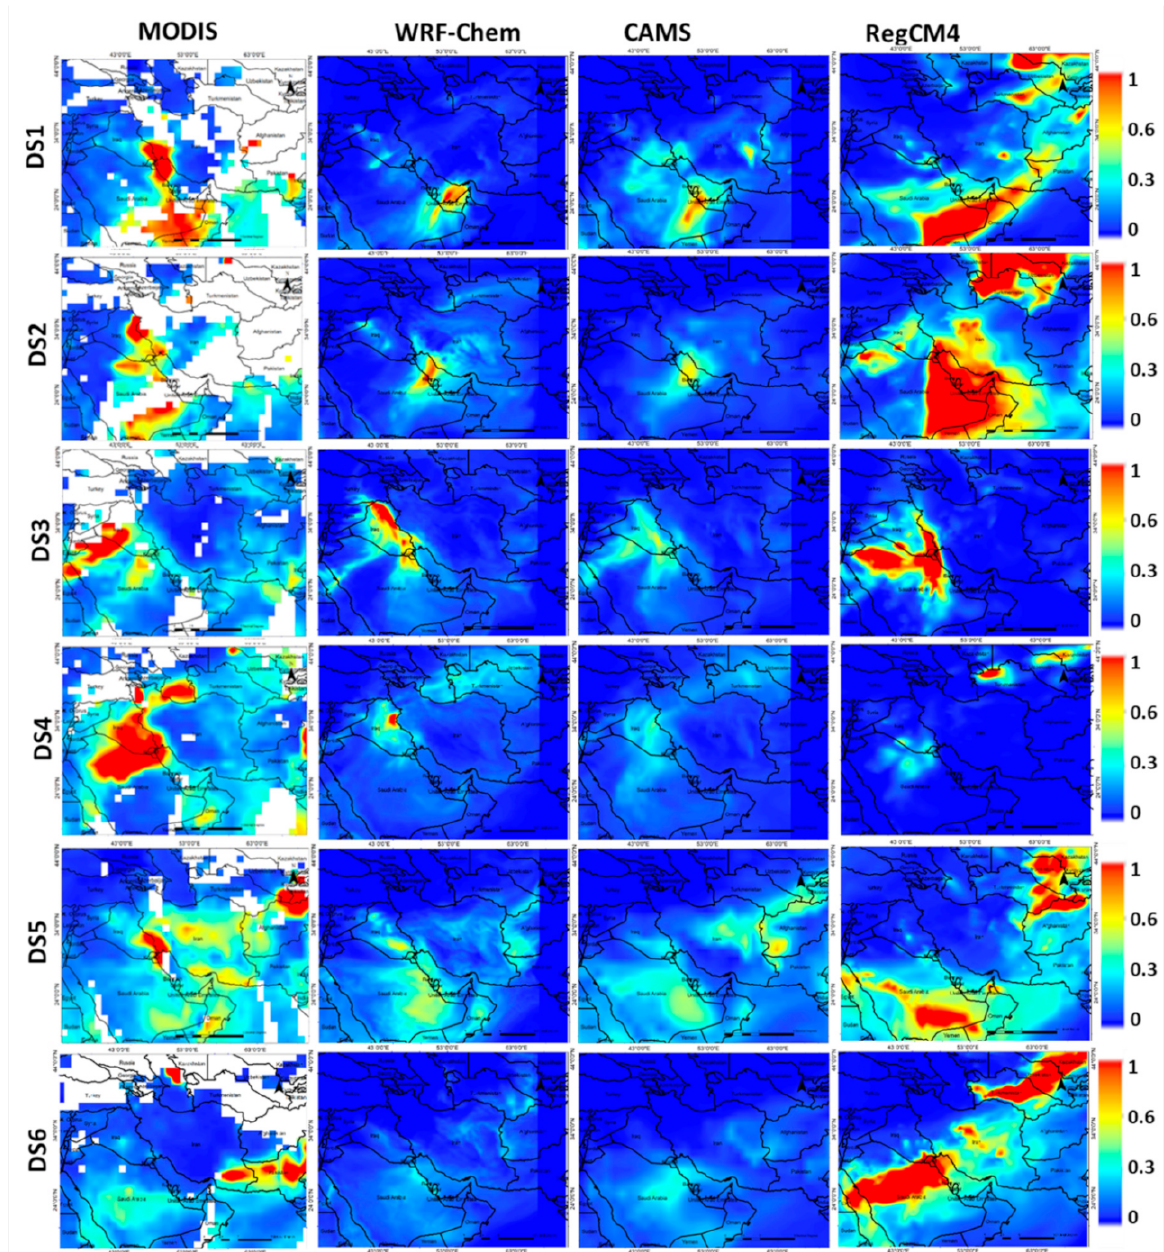
Figure 4. Spatial distribution of the Terra-MODIS aerosol optical depth (AOD 550 ) and simulated AODs (at 9:00 UTC) via Weather Research and Forecasting model coupled with Chemistry (WRF-Chem), Copernicus Atmospheric Monitoring Service (CAMS) and Regional Climate Model-4 (RegCM4) models over the Middle East region on 17 February 2017 (DS1), 1 February 2017 (DS2), 19 January 2018 (DS3), 30 October 2017 (DS4), 1 October 2016 (DS5), 9 December 2016 (DS6). [LST = UTC +